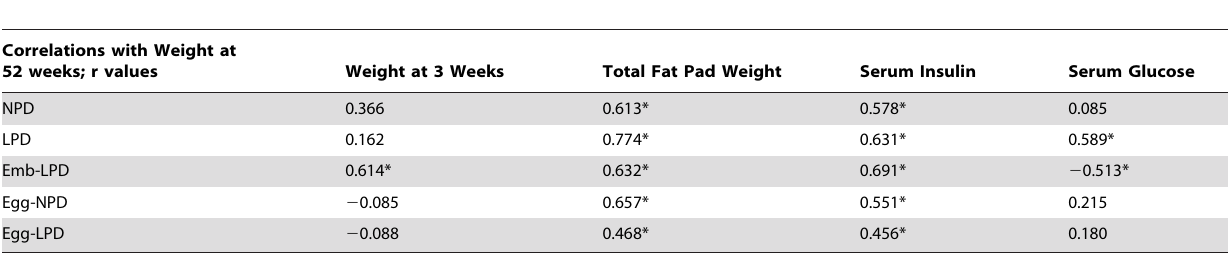
Table 7. Correlations of adult body weight (at 52 weeks of age) with perinatal weight (at 3 weeks of age), adult mean total fat pad weight and serum insulin and glucose levels.